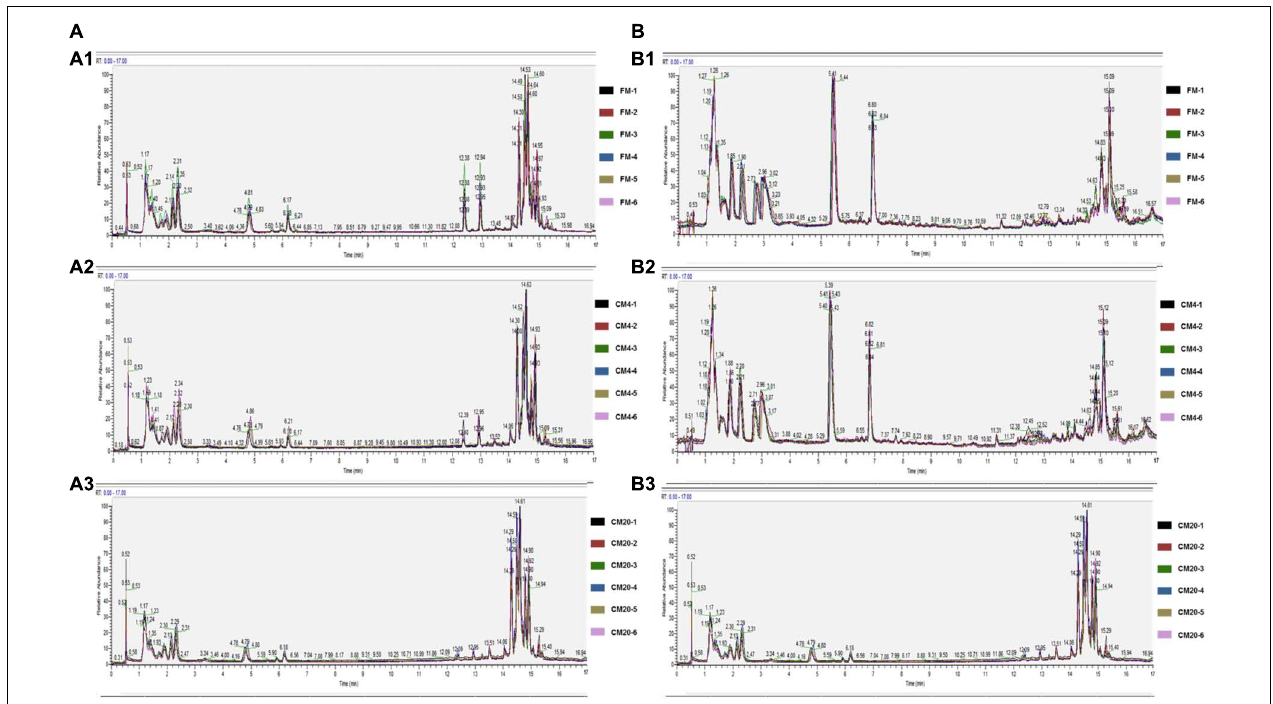
FIGURE 3 | The representative UPLC-MC spectra of the distal intestine in positive (A) and negative (B) modes. (A1,B1) Respectively represent the individual sample repeats of FM in positive and negative modes, (A2,B2) respectively represent the individual sample repeats of CM4 in positive and negative modes, and (A3,B3) respectively represent the individual sample repeats of CM20 in positive and negative modes. Abbreviations are as defined in Figure 1